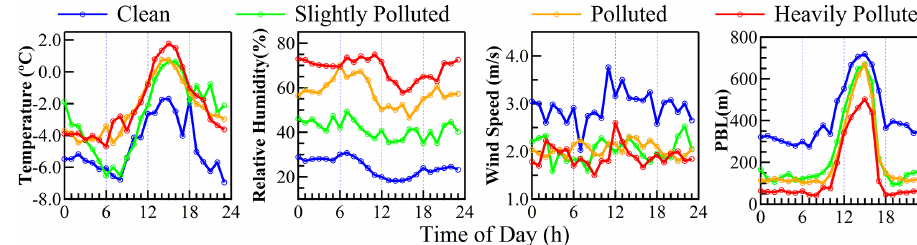
Figure 5. Mean diurnal variation in meteorological parameters for different pollution levels.